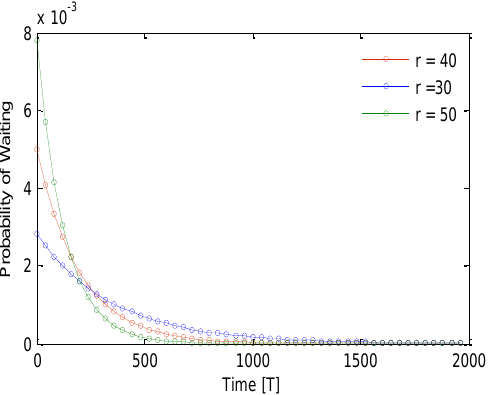
Figure 9. Probability of waiting for a definite time for sending the HelloRep packet.